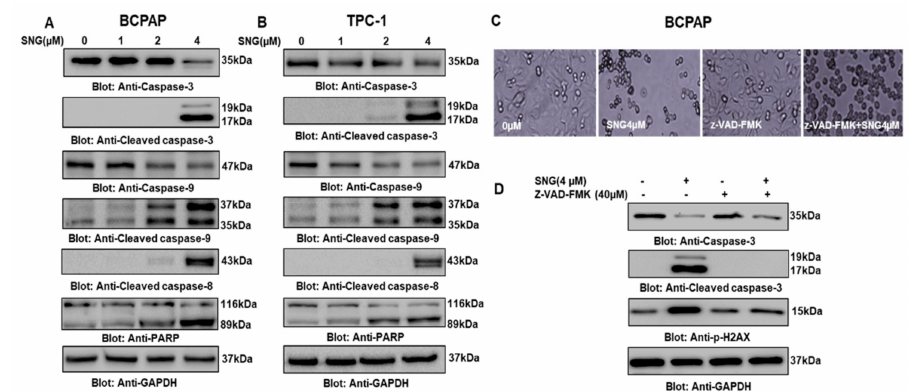
Figure 3. SNG-mediated activation of caspase cascade in PTC cells. SNG-induced activation of caspase-9, caspase-3, and cleavage of PARP in PTC cells. BCPAP ( A ) and TPC-1 ( B ) cells